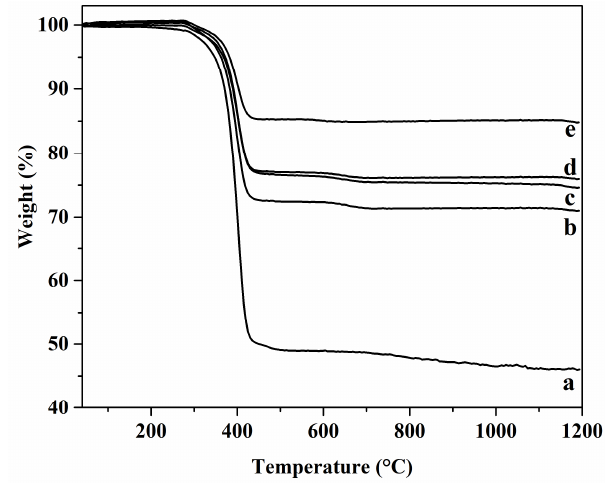
Figure 8. Results of thermogravimetric analysis of composite samples (a: PCL/CaP_Si0; b: PCL/CaP_Si1, c: PCL/CaP_Si2, d: PCL/CaP_Si3, e: PCL/CaP_Si4).